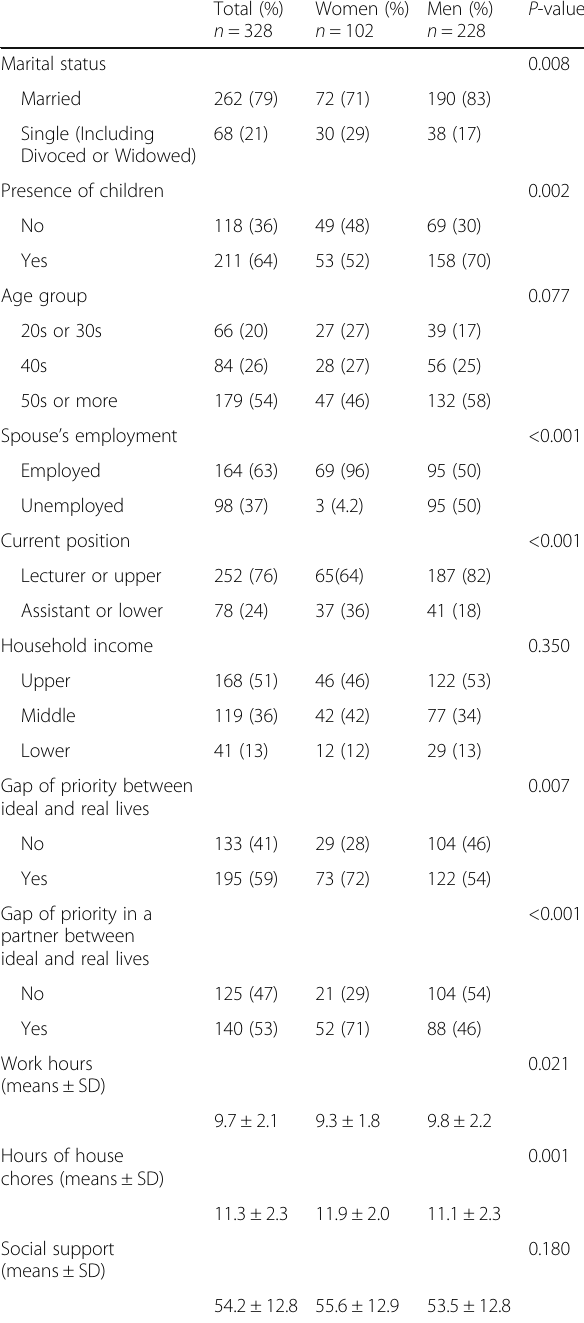
Table 1 Baseline characteristics and working